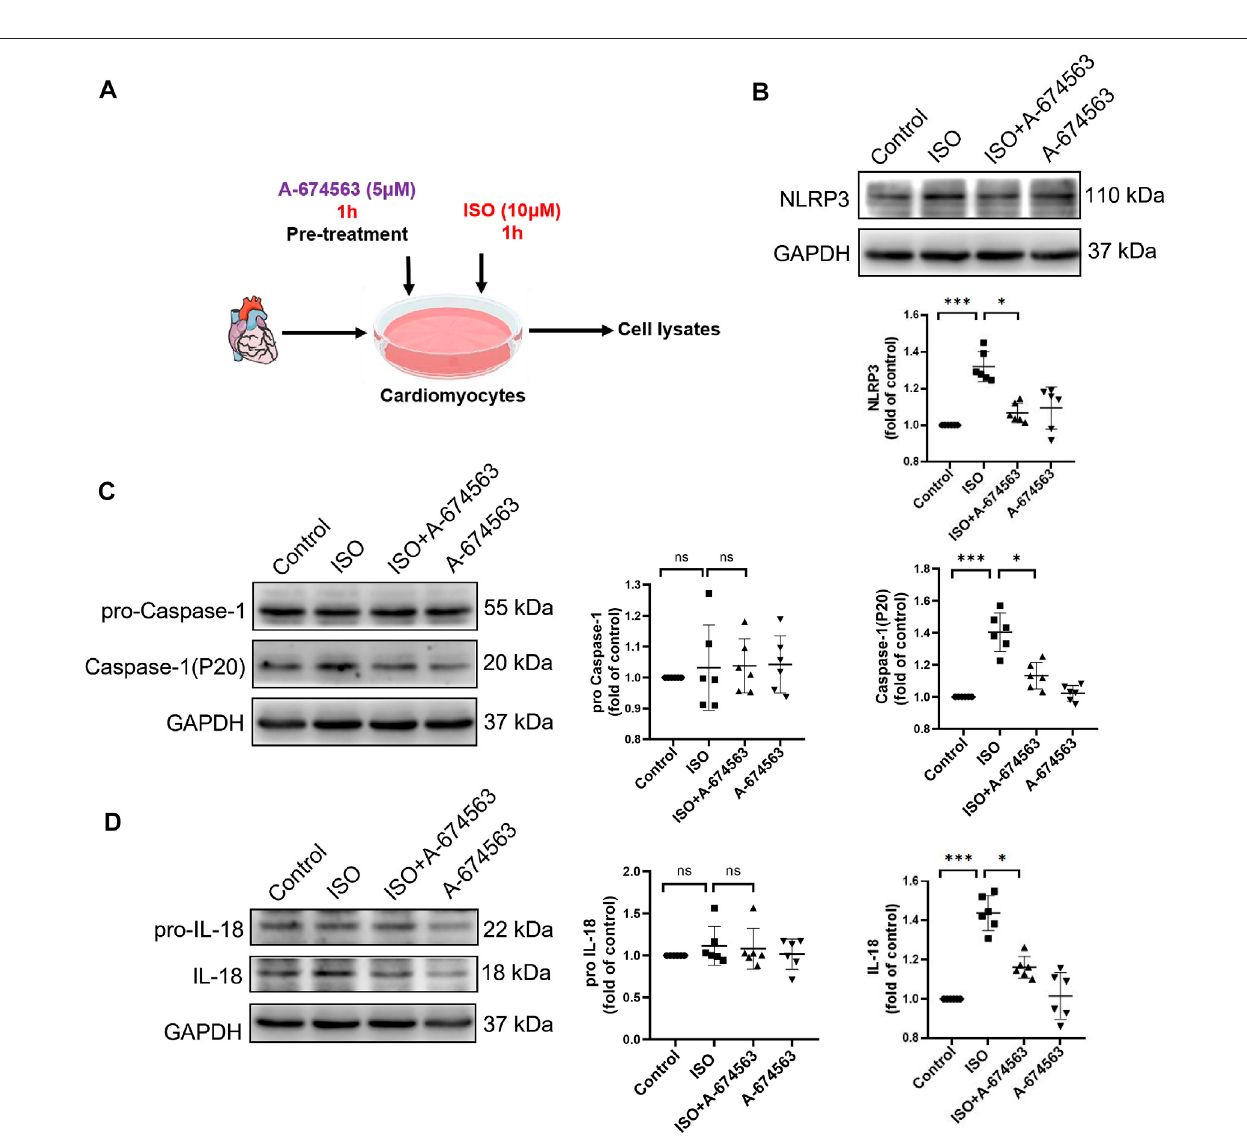
FIGURE4| A-674563inhibitsisoproterenol-inducedactivationoftheNLRP3in fl ammasomeinNMCM.NMCMswereexposedtoisoproterenol(10 μ mol/L)for1 h with or without A-674563 (5 μ mol/L) pretreatment for 1 h. (A) Mode in NMCMs. (B – D) The protein levels of NLRP3, pro-caspase-1, caspase-1(P20), pro-IL-18, and cleaved IL-18 were detected by western blotting. n = 6; * p < 0.05; ** p < 0.01; *** p < 0.001; RES, Resveratrol; ISO, isoproterenol. Data are mean ± SD (Kruskal-Wallis ANOVA with post-hoc Dunn ’ s multiple comparison tests).